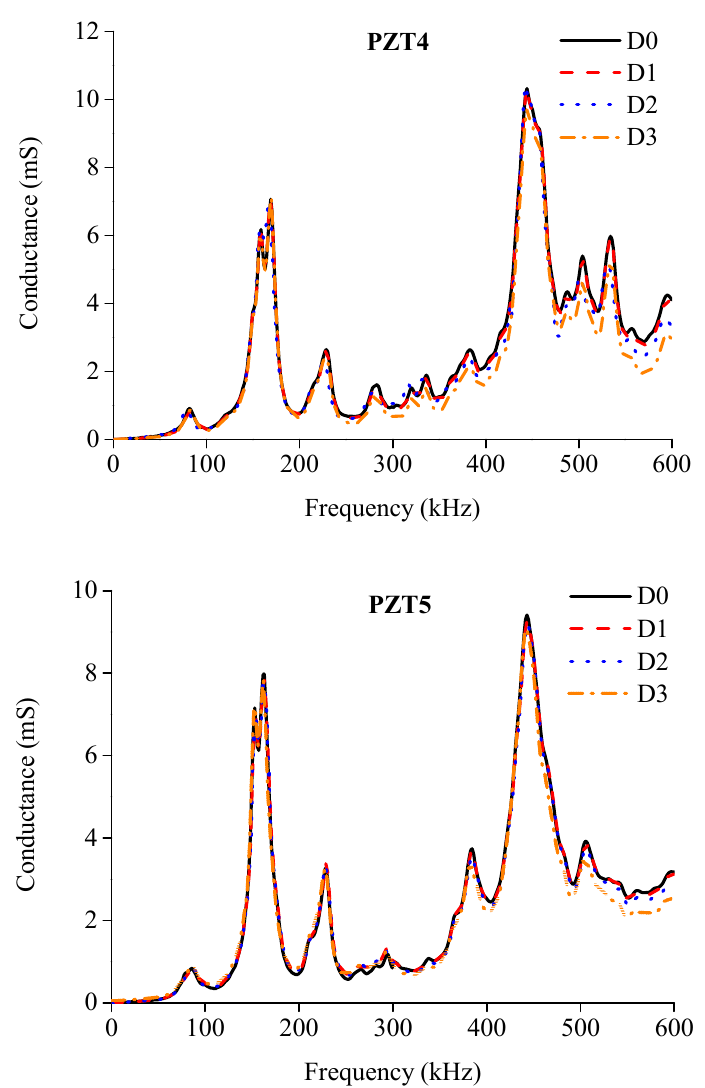
Figure 10. Comparisons of electrical conductance signature of each PZT sensor under different damage levels of BE2.